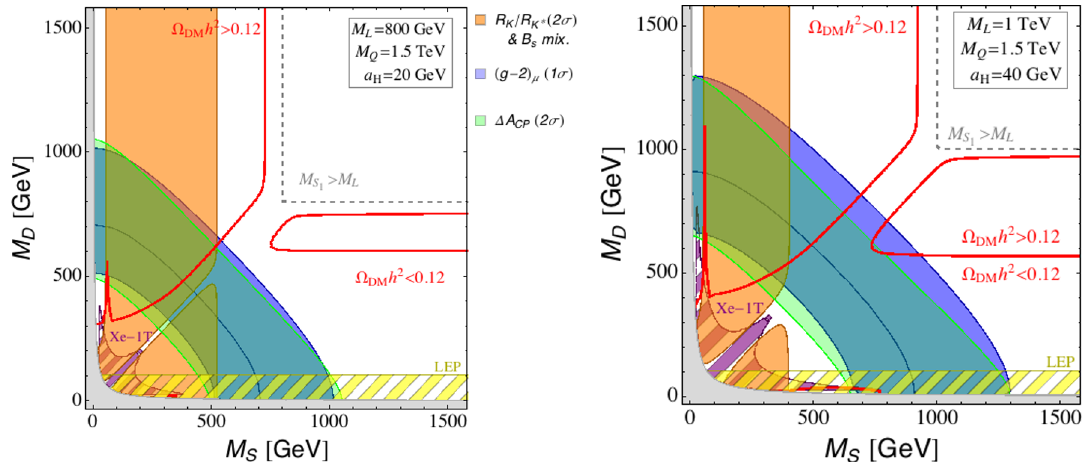
Figure 9 . Combined constraints on the singlet-doublet mass plane ( M S , M D ). The couplings are set to representative values following the discussion in section 3: (cid:21) Q (cid:21) E = (cid:0) 1, Im( (cid:21) U ) = (cid:0) 1 : 5 (left panel), (cid:0) 1 (right panel). All other couplings are set to zero. Cf. the 2 1 main text for further